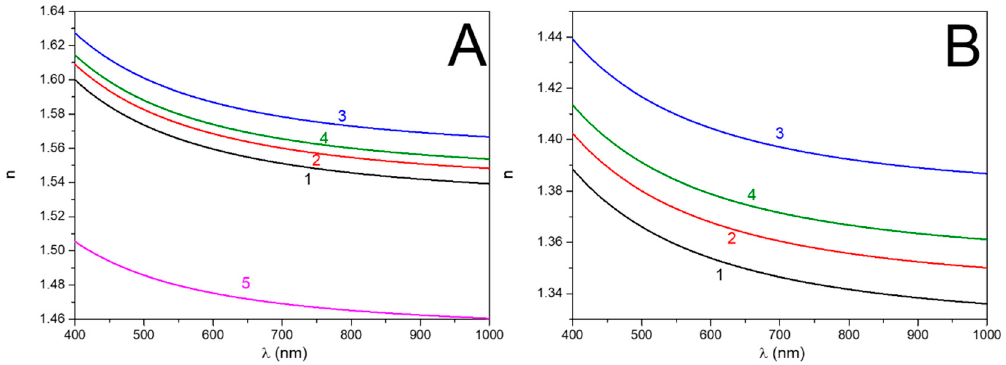
Figure 5. Refractive index dispersion of pAAO / X ( A ): (1) pAAO / PBS, (2) pAAO / HSA (1 h incub.) , (3) pAAO / HSA (2 h incub.) , (4) pAAO / HSA (3 h incub. + 15 min wash) , and (5) pAAO / air; ( B ) Refractive index dispersion inside nanoporous layer filled with: (1) PBS, (2) HSA after one 1 h incubation, (3) HSA after 2 h incubation, and (4) HSA after 3 h incubation followed by 15 min wash.